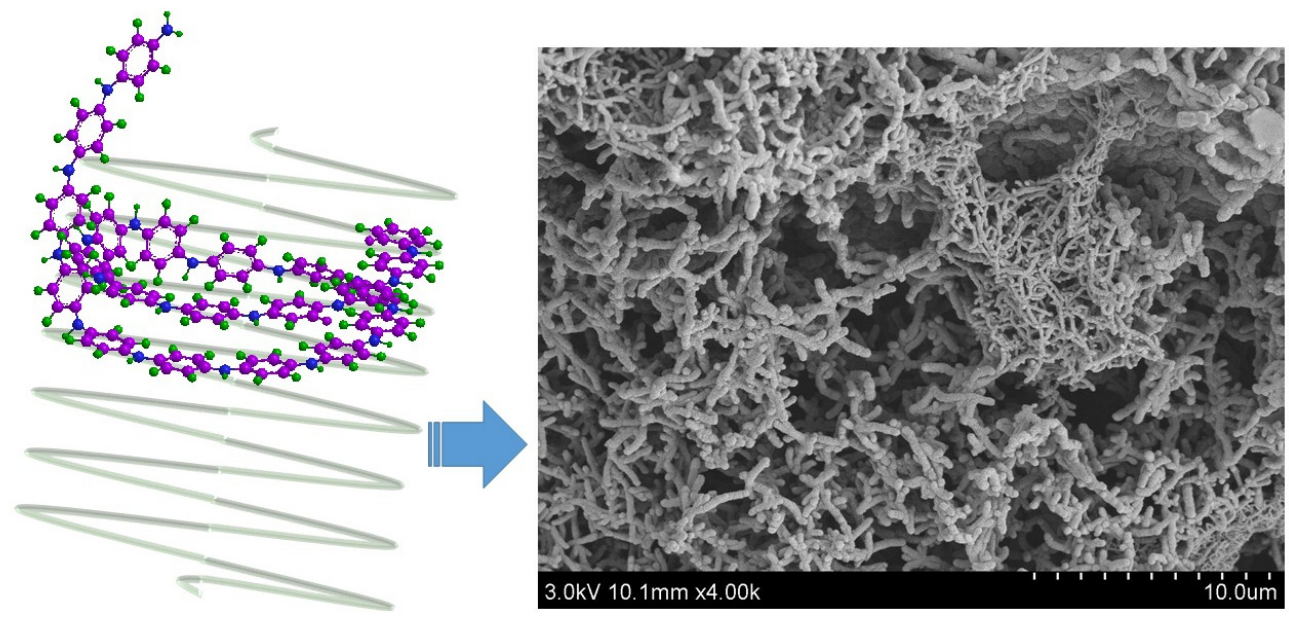
Figure 9. Coiling and supercoiling of the linear and long chains of polyaniline to form spindle morphology (initial and intermediate stages of fiber formation).